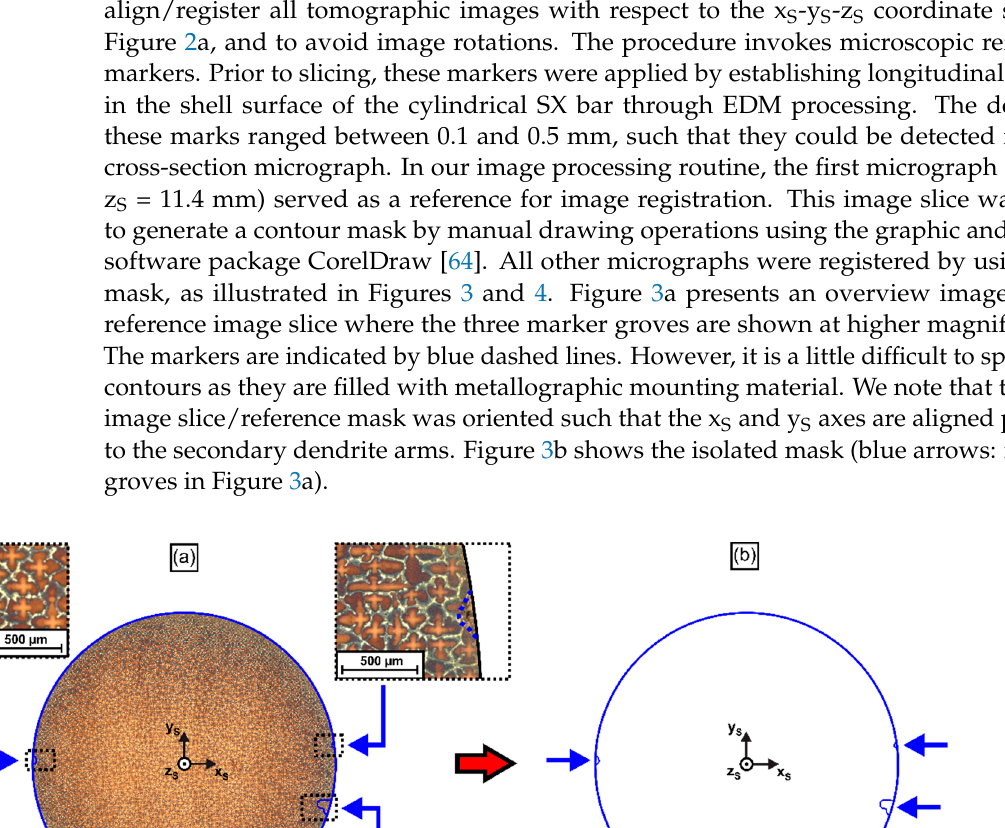
Figure 4. Alignment/registration of sample slices from different height positions using the reference mask. ( a ) Reference mask from first sample slice, see Figure 3. ( b ) Raw image from a slice extracted from a higher z S position. ( c ) Same image as in ( b ) after alignment using the reference mask ( a ). The high magnification micrographs document that a good match between image and reference mask was obtained. Blue arrows: EDM notches in reference mask. Red arrows: EDM notches in target image. For details see text. Data analysis and visualization: Two different approaches for data analysis and visual- ization were applied in the present study. The first approach aims for a reconstruction of dendrite growth directions. Central positions of primary dendrite arms were determined from registered images by manual coordinate extraction using the software package Im- ageJ [65], followed by a subsequent transformation into x S -y S -z S sample coordinates, Fig- ure 2a. An example for this procedure is presented in Figure 5. Figure 5a shows a small part of a micrograph from the first sample slice, corresponding to a z S position of 11.4 mm. The small red crosses indicate centroids of primary dendrite arms growing opposite to the